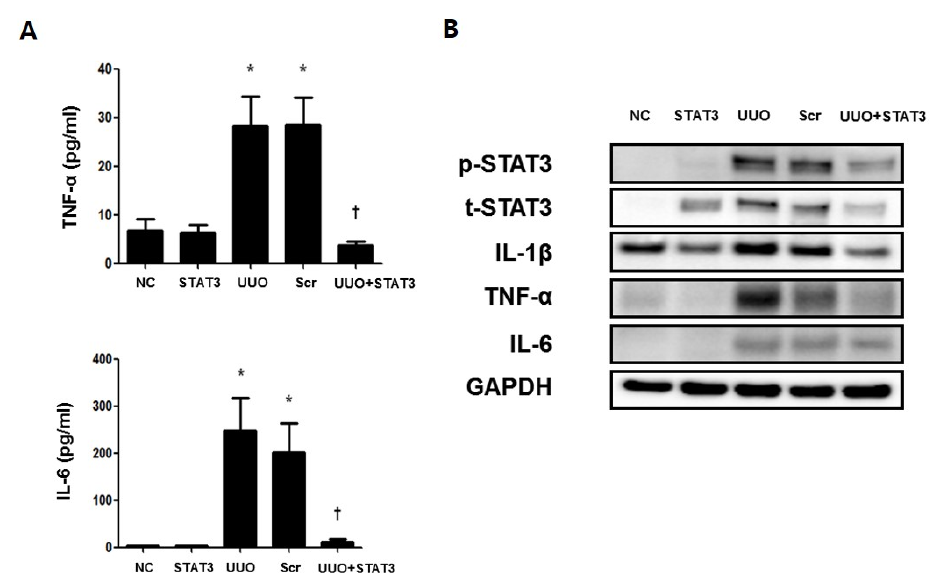
Figure 4. Regulation of Inflammatory Cytokines in the UUO-induced Renal Fibrosis Model by STAT3 Decoy ODNs. The inflammation regulatory effects of STAT3 decoy ODN in obstructive kidney. ( A ). Inhibitory effects of STAT3 on UUO-induced change in serum levels of TNF- α and IL-6 were measured through an ELISA kit ( n = 5) ( B ) Western blot analysis shows that STAT3 decoy ODN decreased the expressions of inflammatory cytokines such as IL-1 β , TNF- α , and IL-6. Western blot results show that STAT3 decoy ODN inhibits the expression of p -STAT3. * p < 0.05 vs. NC, † p < 0.05 vs. UUO. Abbreviations: UUO, unilateral ureteral obstruction; decoy ODNs, decoy oligonucleotides; STAT3, signal transducer and activator of transcription 3; Scr, scrambled; α -SMA, α -smooth muscle actin; IL-1 β , interleu-kin-1 β ; TNF- α , tumor necrosis factor- α ; IL-6,